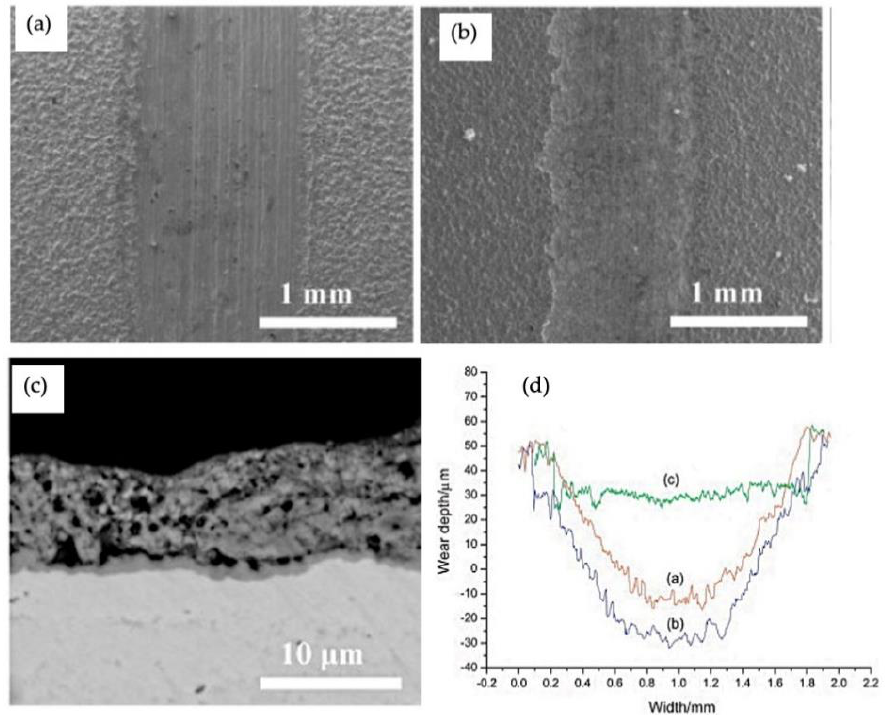
Figure 5. ( a , b ) The sliding impact on surface morphologies for the silicate and aluminate PEO coating, respectively; ( c ) cross-section image of the sliding scar at the center of the PEO coating formed in aluminate electrolyte for 600 s [53] (Reproduced with permission number: 5043480179625, Elsevier); ( d ) wear scars profile after dry sliding under 10 N load on PEO coatings formed in electrolyte mixture of aluminate and KOH for various treatment times: a. 5 min, 30 min sliding time; b. 10 min, 923 s sliding time; c. 30 min, 30 min sliding time [54] (Reproduced with permission number: 5043510569542, Elsevier).